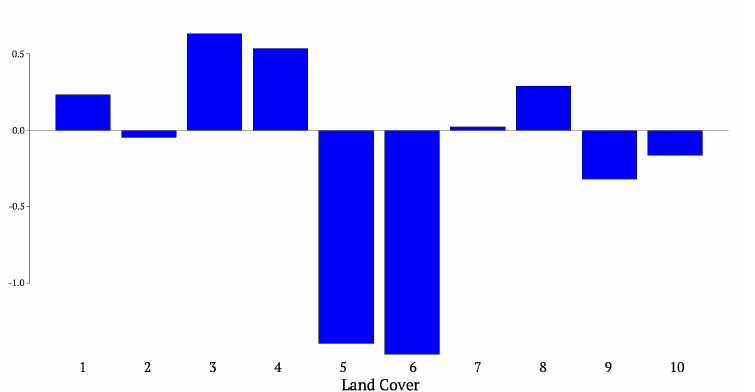
Figure 10. Partial dependence plot on the explanatory variable land cover. See Table for class descriptions.